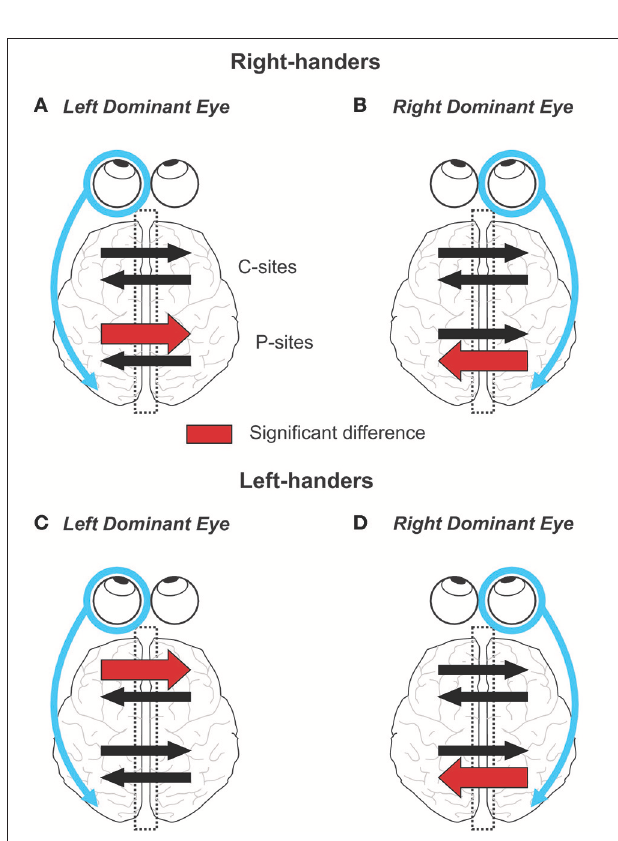
FIGURE 8 | Graphical summary of the results. On each panel, the encircled eye indicates the DE and the connected arrow its preferential relationship with its ipsilateral hemisphere (Shima et al., 2010; Chaumillon et al., 2014). Concerning the IHTT over the posterior sites (P-sites), the present experiment revealed that in right-handers, the asymmetry in IHTT strictly depends on the eye dominance. Indeed, right-handers with a left DE (A) show faster interhemispheric transfer from left to right than from right to left whereas right-handers with a right DE (B) show the opposite pattern. In left-handers, individuals with a left DE (C) show no asymmetry whereas individuals with a right DE (D) show a faster interhemispheric transfer from right to left than from left to right. Concerning the IHTT over central sites (C-sites), right-handers show no difference between the two interhemispheric transfer directions. On the contrary, left-handers with a left DE show faster IHTT from left to right whereas left-handers with a right DE show no difference between the two interhemispheric transfer